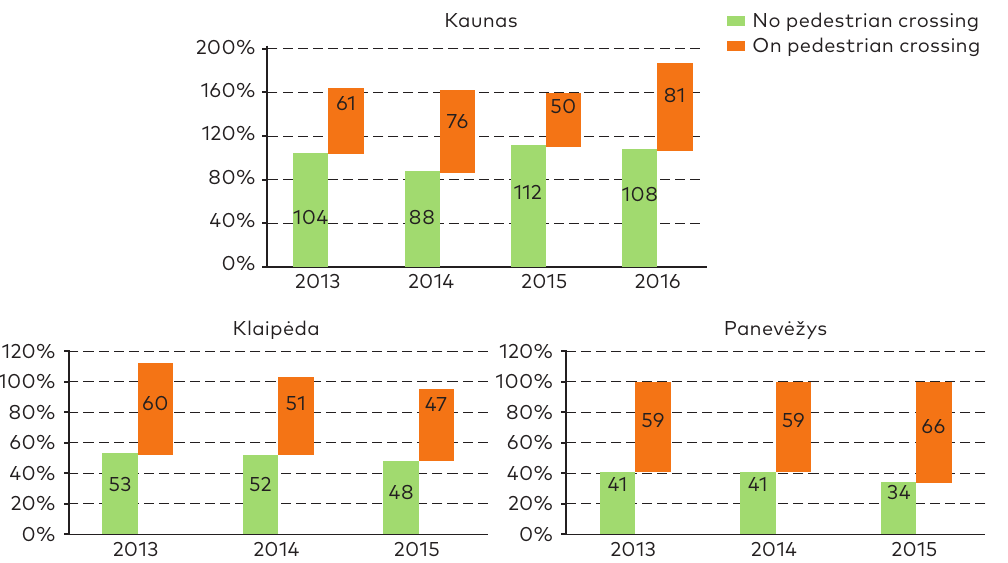
Figure 5. Pedestrian collisions in three largest Lithuanian